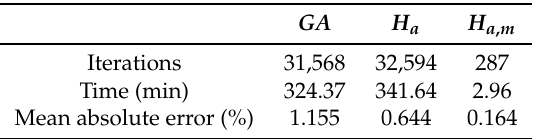
Table 3. Comparisons on iterations, time cost and mean absolute